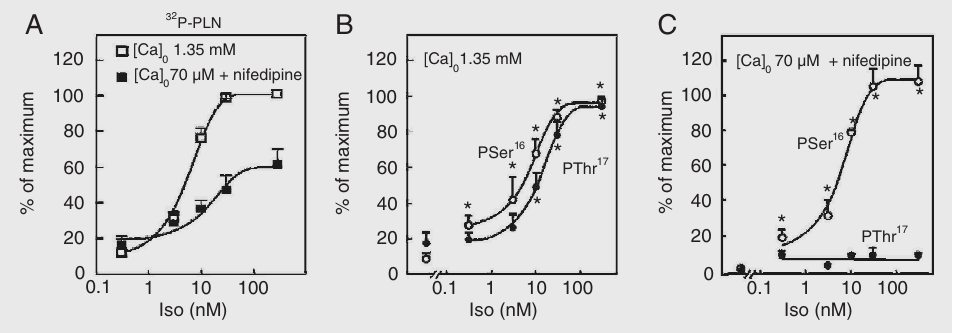
Figure 3. Isoproterenol (Iso) concentration-dependent increase in 32 P incorporation into phospholamban (PLN) and in the phosphorylation of Ser 16 and Thr 17 residues at two different levels of extracellular Ca 2+ . A , Rat hearts were perfused with 32 P and then with different isoproterenol concentrations at two different levels of Ca 2+ . The virtual suppression of Ca 2+ supply to the heart (70 µM (Ca) o + 0.4 µM nifedipine) significantly decreased 32 P incorporation into PLN ( 32 P-PLN), at 10, 30 and 300 nM Iso, but failed to affect it at 0.3 and 3 nM Iso. Data are reported as percent maximal 32 P incorporation into PLN. B and C , Densitometric analysis of the signal of immunoblots of sarcoplasmic reticulum membrane vesicles isolated from rat hearts perfused with different Iso concentrations at two (Ca 2+ ) o , and probed with anti-PSer 16 -PLN and anti-PThr 17 -PLN. At 1.35 mM (Ca) o , Iso increased the phosphorylation of both Ser 16 and Thr 17 (B). Phosphorylation of Thr 17 was shifted to the right relative to the increase in the phosphorylation of Ser 16 . The decrease in (Ca 2+ ) o , as shown in panel A, did not significantly affect the phosphorylation of Ser 16 but inhibited the increase in the phosphorylation of Thr 17 at all Iso concentra- tions (C). Data are reported as percent of the maximal signal achieved in each experimental series. *P < 0.05 compared to no drug values at normal (Ca 2+ ) o (B) and at low (Ca 2+ ) o (C) (Student t -test for unpaired samples). Modified from Ref. 15, with